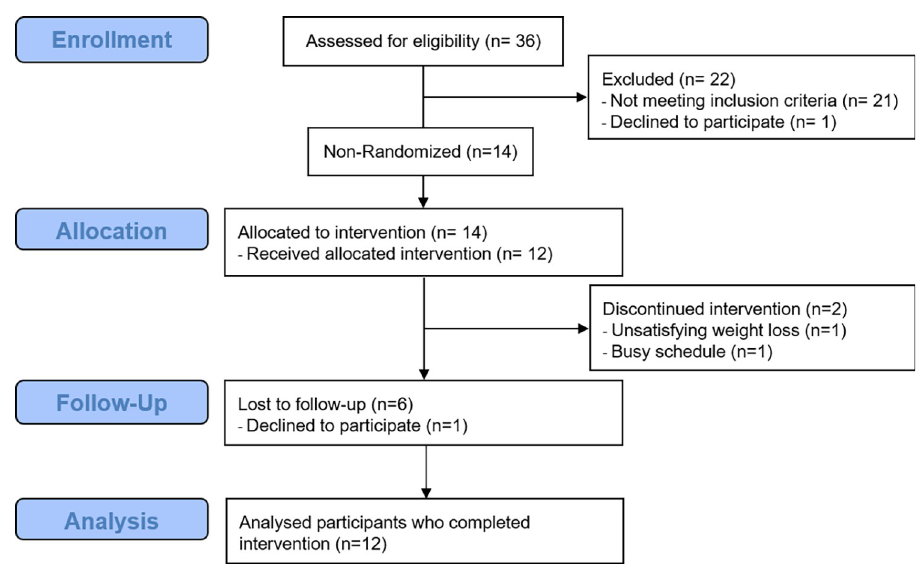
Fig 1. Flow diagram of the